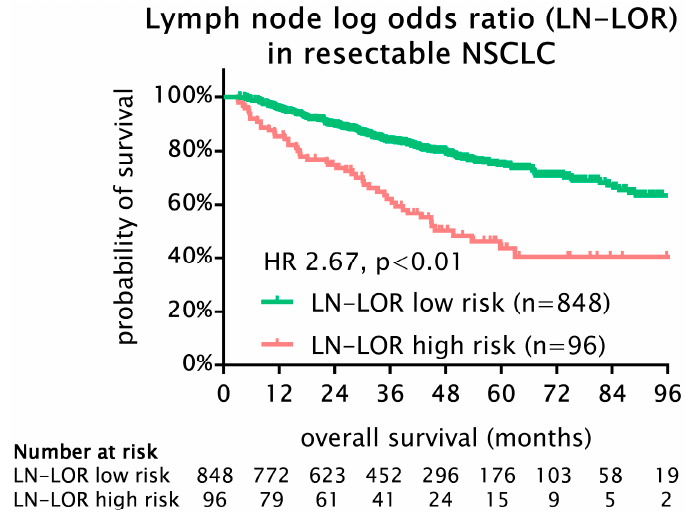
Figure 1. Kaplan–Meier survival analysis for OS in 944 patients with stage I-III NSCLC undergoing curative intent lobectomy. Lymph node log-odds ratio high-risk patients had a statistically significant and clinically relevant worse OS compared to low-risk patients (5-year OS 44% vs. 75%; HR 2.67, 95% CI 1.90–3.93, p < 0.001). NSCLC, non-small cell lung cancer; LN-LOR, lymph node log-odds ratio; HR, hazard ratio.